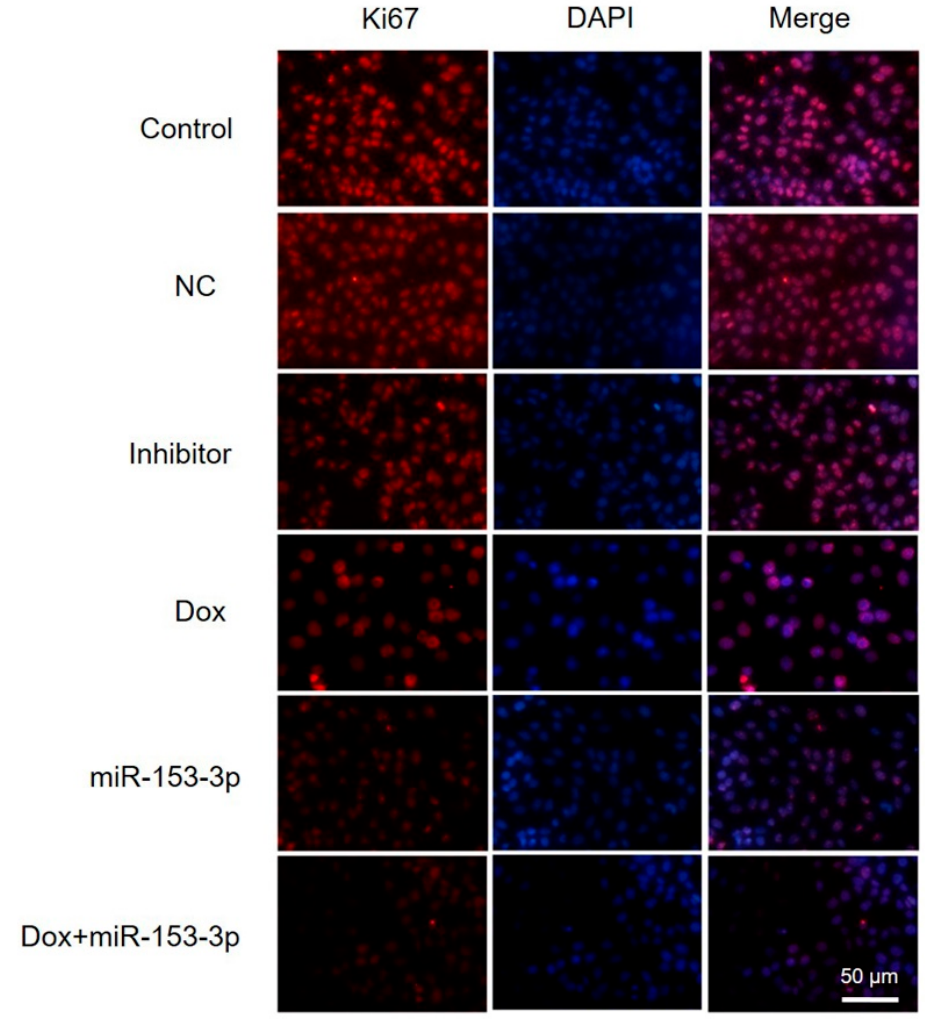
Figure 2. Immunofluorescence indicating Ki67 expression in MCF-7 cells after miR-153-3p and Dox treatment. MCF-7 cells were transfected with NC, inhibitor, miR-153-3p or Dox, and miR-153-3p+Dox for 24 h. Scale bar = 50 μ m.